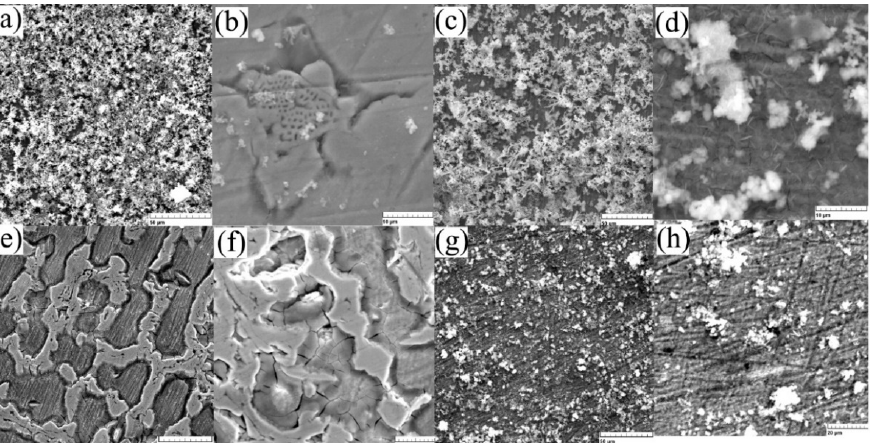
Figure 5. SEM images of the surface: ( a ) C sample after 1 day immersion (1 kx) and ( b ) after ultrasound cleaning (5 kx), ( c ) W sample after 1 day immersion (1 kx) and ( d ) after ultrasound cleaning (5 kx), ( e ) C sample after 7 days immersion (1 kx), and ( f ) after ultrasound cleaning (2 kx), ( g ) W sample after 7 days immersion (1 kx) and ( h ) after ultrasound cleaning (2 kx).